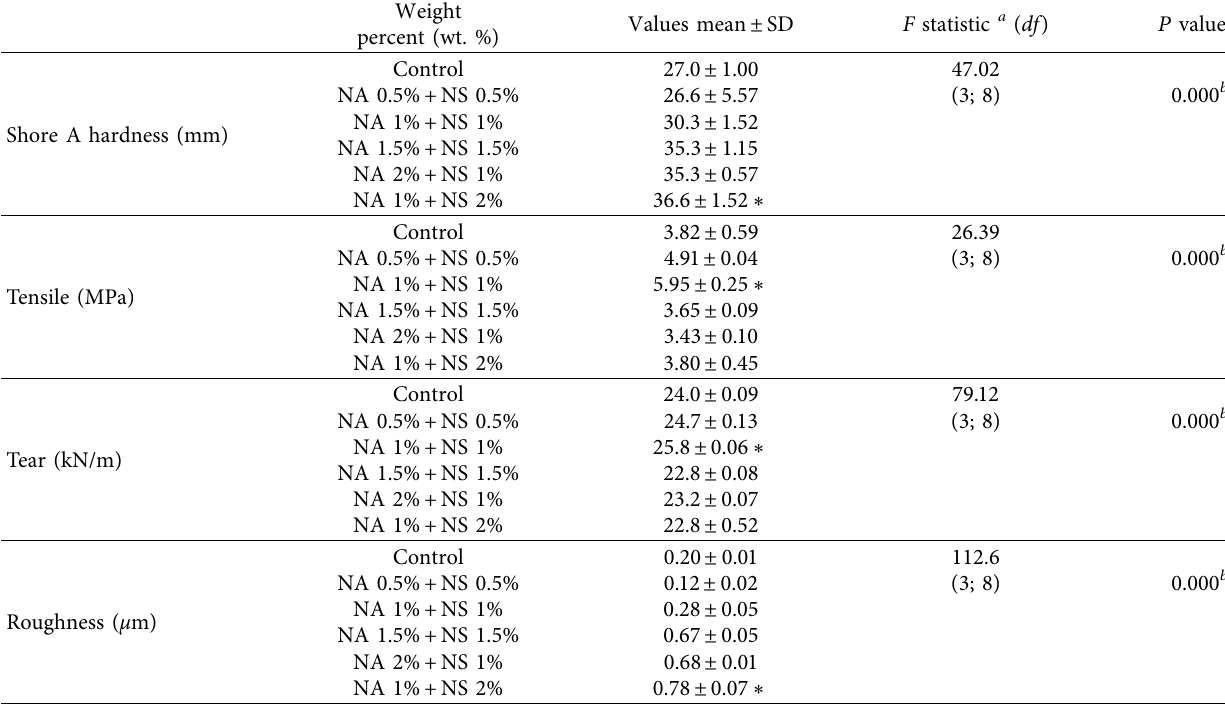
Table 4: Te comparison of addition a combination (NSA) on Tech-sil25 maxillofacial silicone mechanical properties.